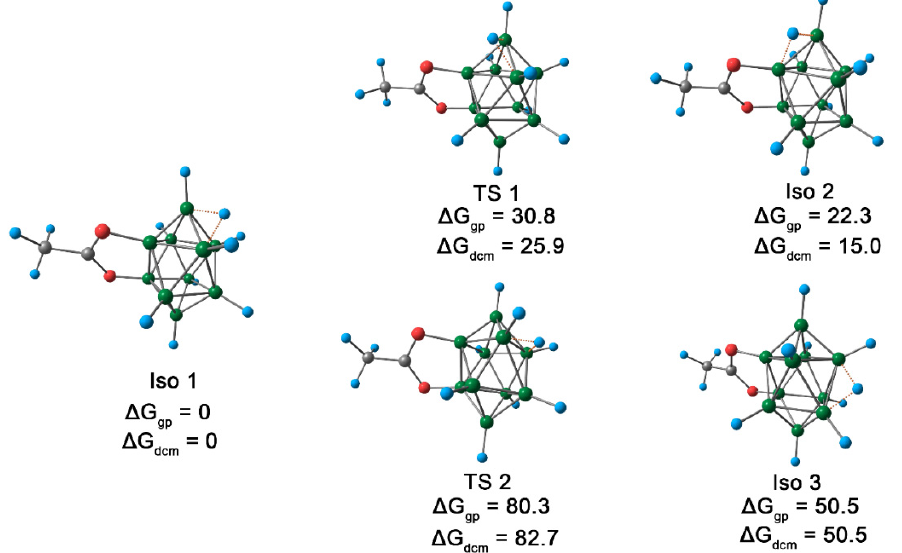
Figure 6. Optimized structures of the main isomers of [2,6-B 10 H 8 O 2 CCH 3 *H fac ] 0 . The atomic designations are given in Figure 1. Δ G gp —relative Gibbs energy of isomer in gas phase. Δ G dcm —relative Gibbs energy of isomer in dichlormethane solution.